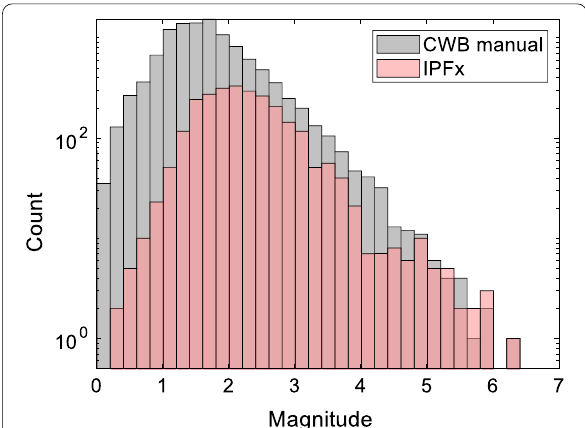
Fig. 3 Histograms of earthquake magnitude for the IPFx and